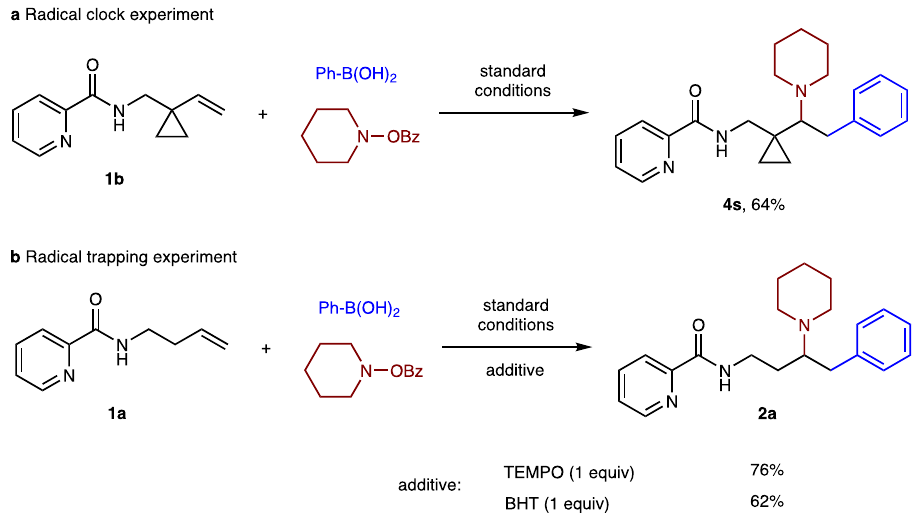
Fig. 7 Mechanistic investigations. a Radical clock experiment with cyclopropyl-containing substrate 1b . b Radical trapping experiment with TEMPO or BHT. TEMPO 2,2,6,6-tetramethyl-1-piperidinyloxy, BHT butylated